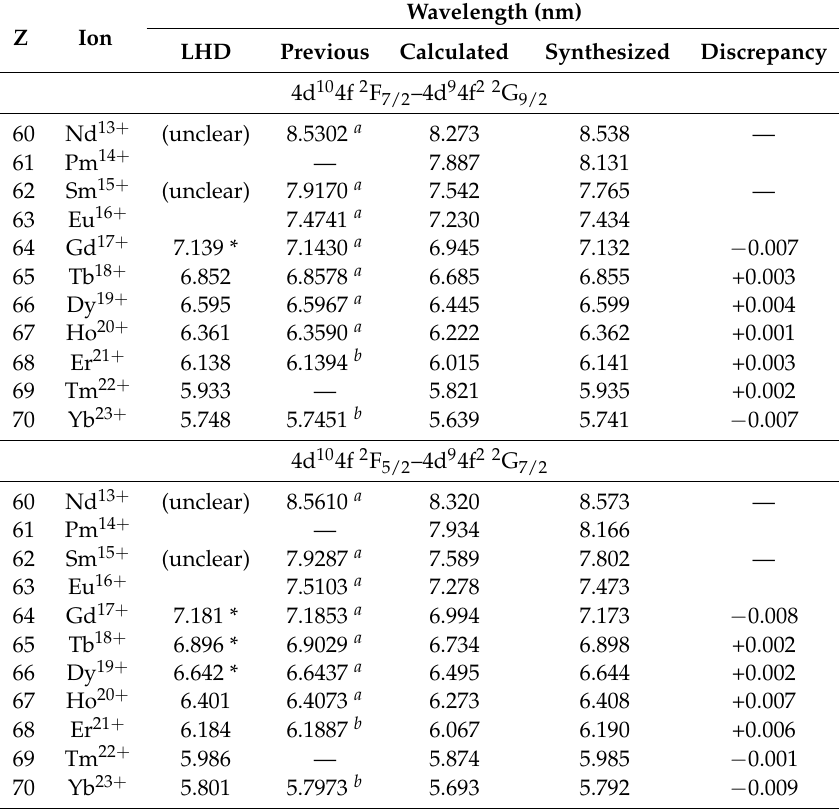
Table 2. Wavelengths of the identified lines of the 4d 10 4f 2 F–4d 9 4f 2 2 G transitions of Ag-like